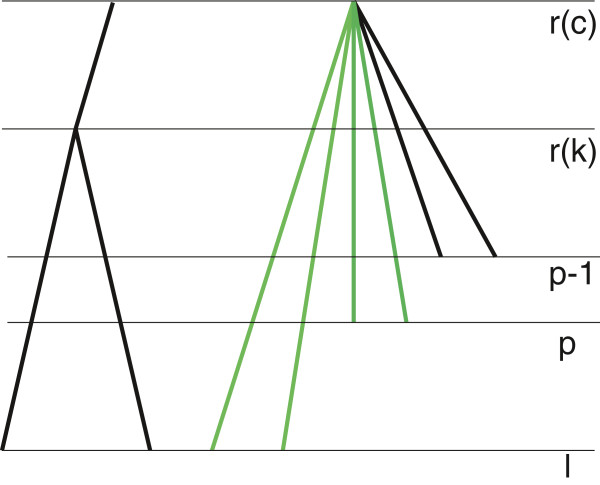
Location of a new node between the (p−1)‐th andp‐th time points. A new node can be placed in subtreec between the (p−1)‐th andp‐th time points if the number of green branches is greater or equal to 2 and the number of all branches in subtreec is greater than 2.